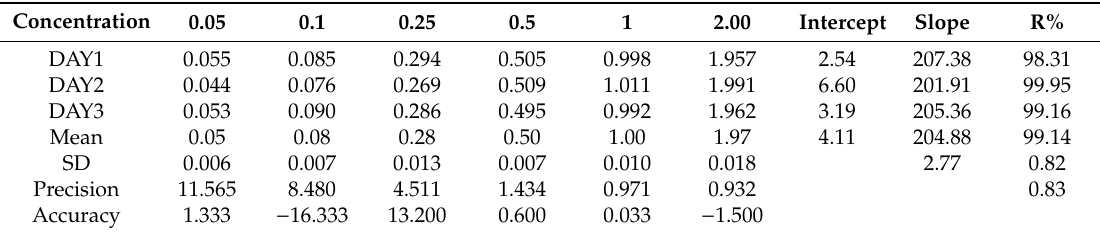
Table 3. Linearity, precision and accuracy of the method for analysis of Galunisertib in mouse plasma samples.